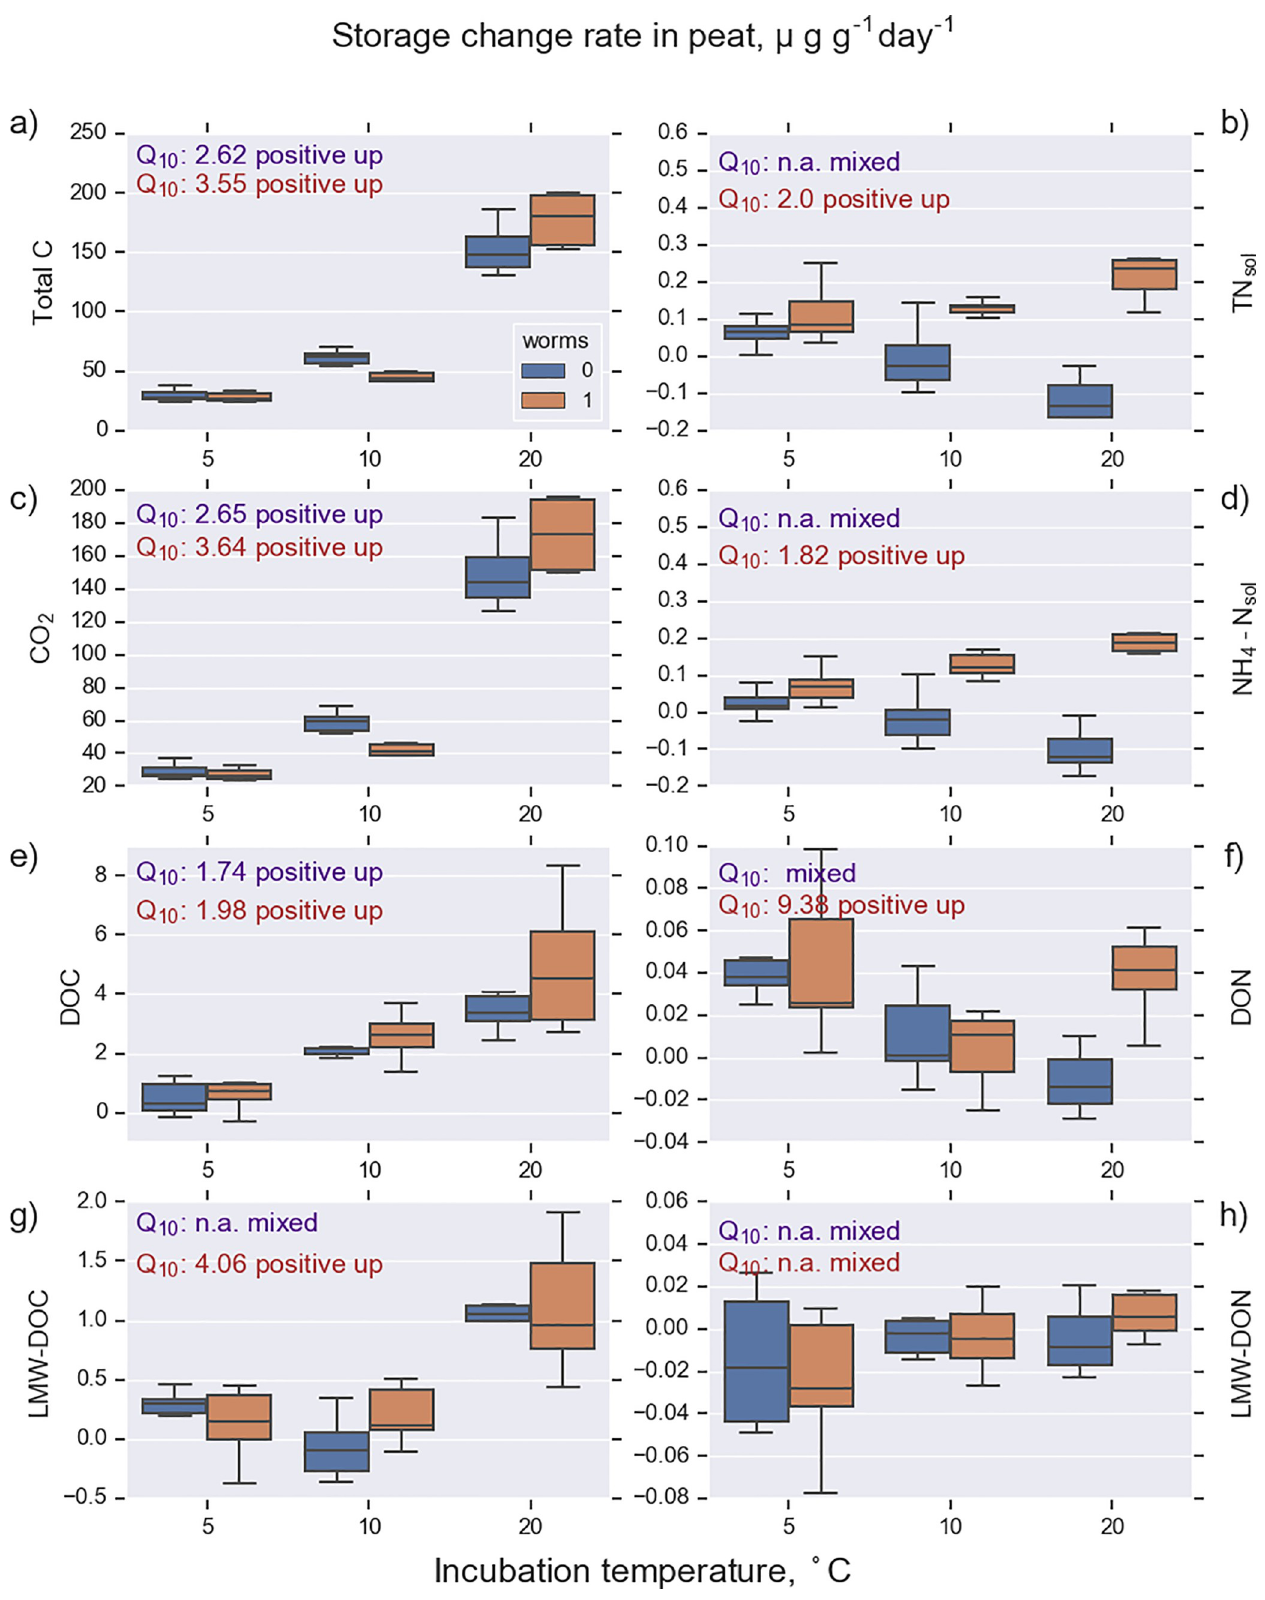
Fig 3. Release rate of CO 2 and rates of change of C and N storage in soil solution collected from peat samples (n = 36). See Table 1 for abbreviations. https://doi.org/10.1371/journal.pone.0223446.g003 PLOS ONE | https://doi.org/10.1371/journal.pone.0223446 October 10,